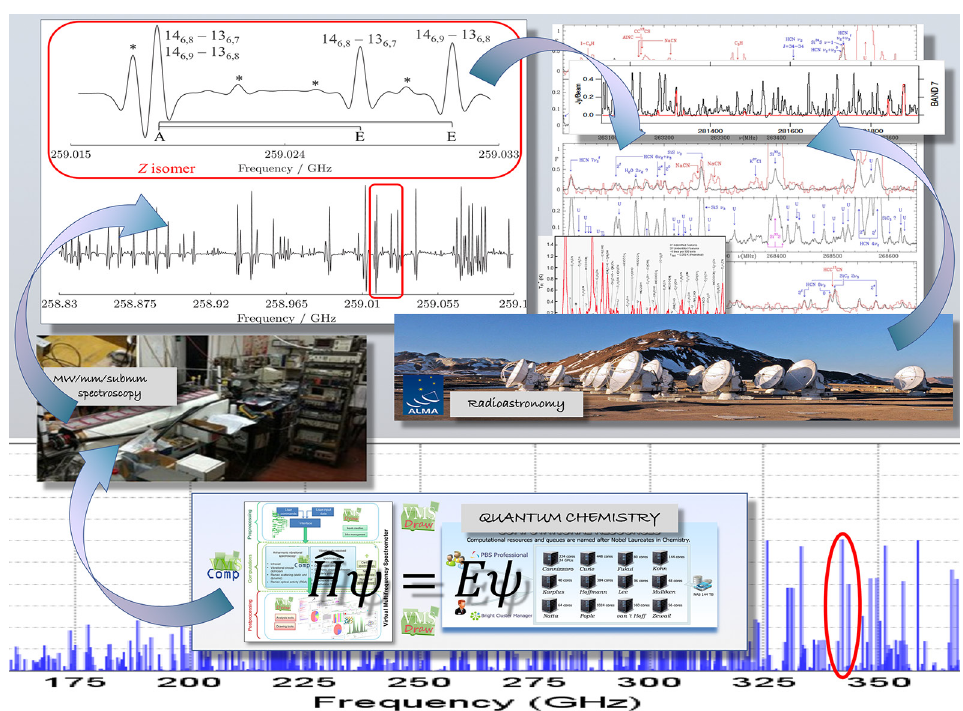
Fig. 3. – Synergism of laboratory, experimental and computational, spectroscopy applied to astronomical